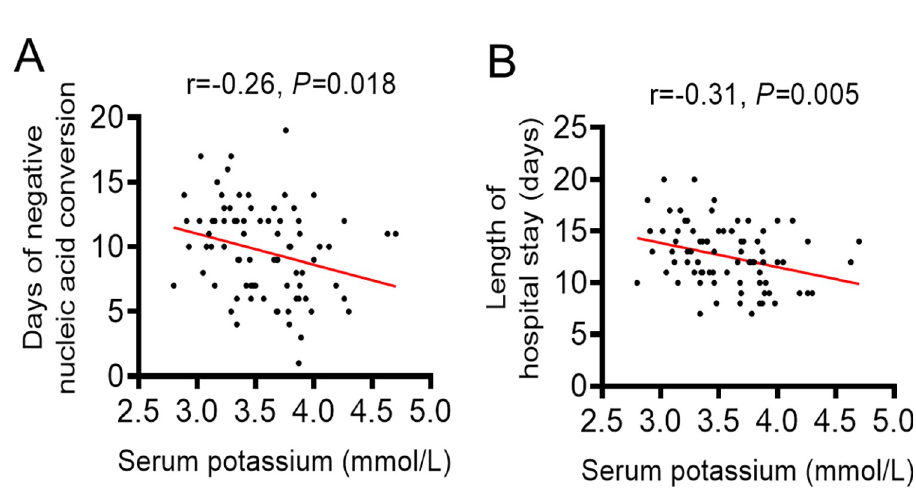
Fig 2. Correlation analysis showed that the level of serum potassium was negatively correlated with days of negative nucleic acid conversion (A) and length of hospital stay (B).